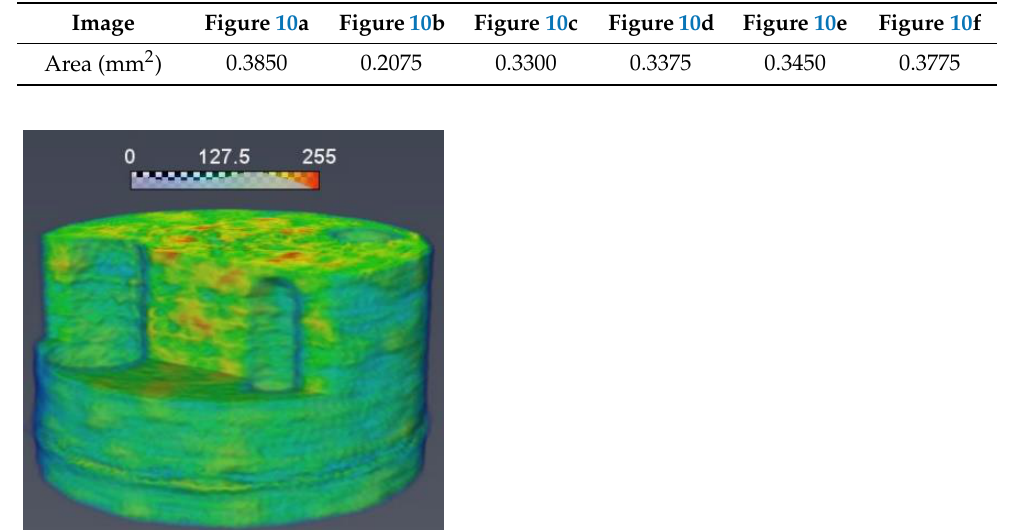
Figure 12. The profile of the reconstructed images. Table 1. The area of high-brightness substance.